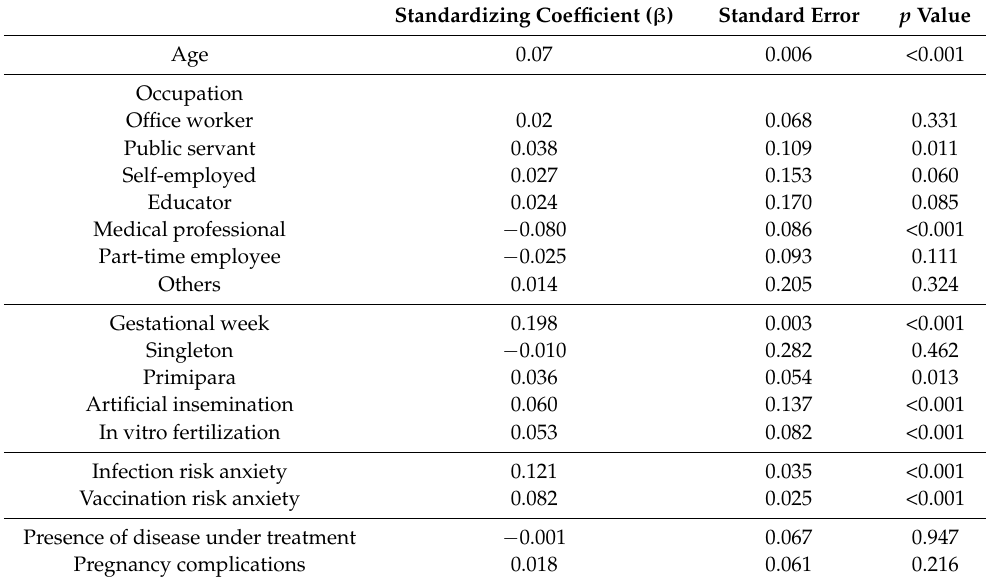
Table 6. Characteristics of pregnant women who used multiple media